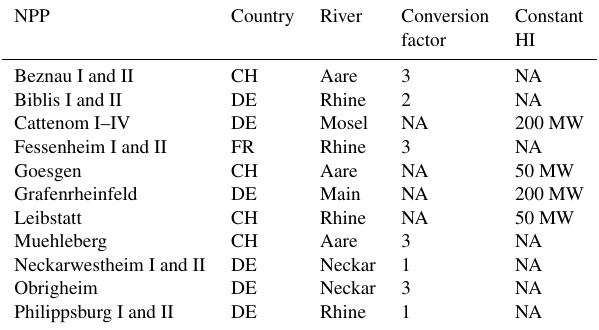
Table 2. NPPs included in this study. The conversion factor de- scribes the conversion from electrical power production (EPP) to heat input (HI). If cooling towers are installed, a constant heat input was used for the calculation based on Lange (2009). Note: NA – not